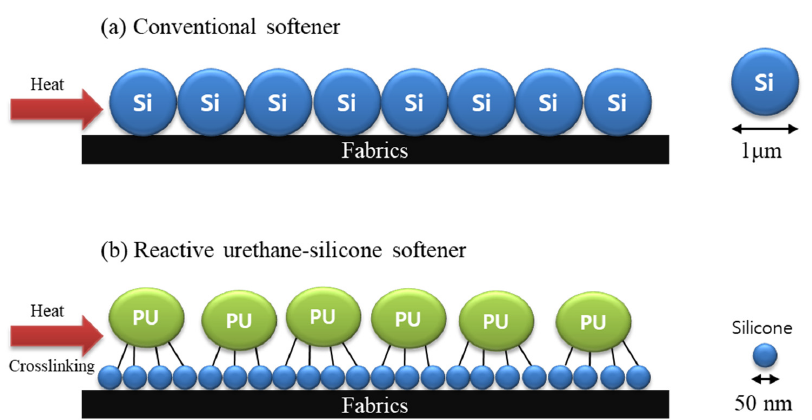
Figure 4. Schematic of conventional softener and reactive urethane-silicone softeners. ( a ) conventional softener; ( b ) reactive urethane-silicone softener.